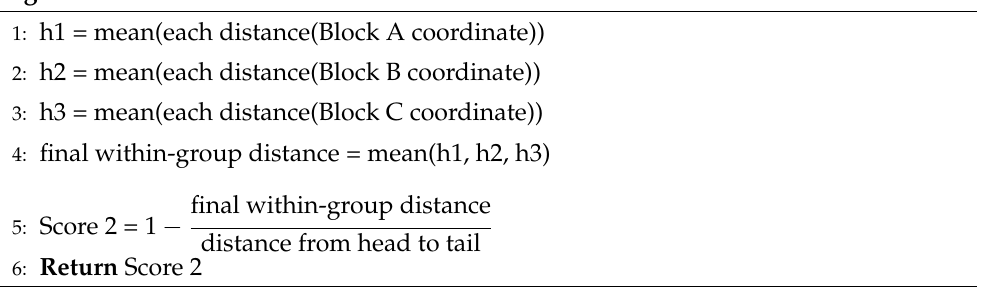
Algorithm 3 Score 2: within-block distance.